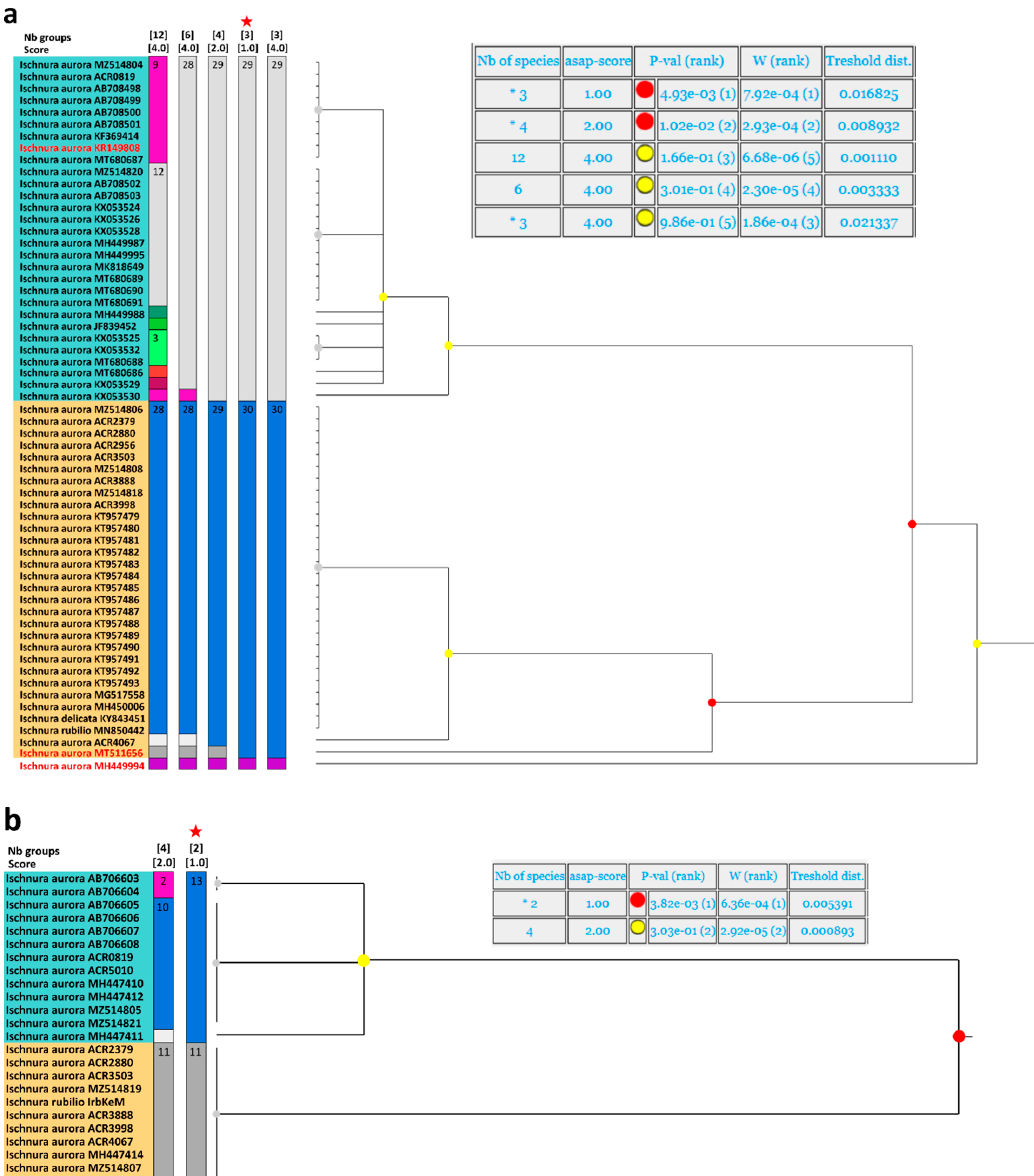
Figure A7. Graphical output of ASAP, showing the results of the species delimitation analysis using the Ischnura aurora ; I. delicata and I. rubilio COI sequences and ( b ) the I. aurora and I. rubilio ITS sequences. Each node of the dendrogram is coloured depending on its probability of being a panmictic species: darker colours for nodes that may be split into smaller groups. The tables show the best partitions found by ASAP in each case, scored and sorted by their p -value (the smallest p-value has rank 1) and their rank of relative barcode gap width (the largest gap has rank 1). The asap-score is the average of both ranks: the smaller the asap-score, the better. The predicted number of groups in each partition, together with their asap-score, are also indicated in the dendrograms, with the red star indicating the best partition according to the analysis in each case. Australo-Pacific and Asian clades are highlighted with the same colours used in Figure 2 in the main text. In ( a ), the individual highlighted in red inside the Australo-Pacific clade corresponds to a specimen of I. aurora from India. The individuals highlighted in red at the bottom of the dendrogram correspond to the specimens of I. aurora from India and New Guinea with COI sequences that are ~2% divergent from the rest of the sequences included in the analyses and identified as belonging to a different species in the ASAP